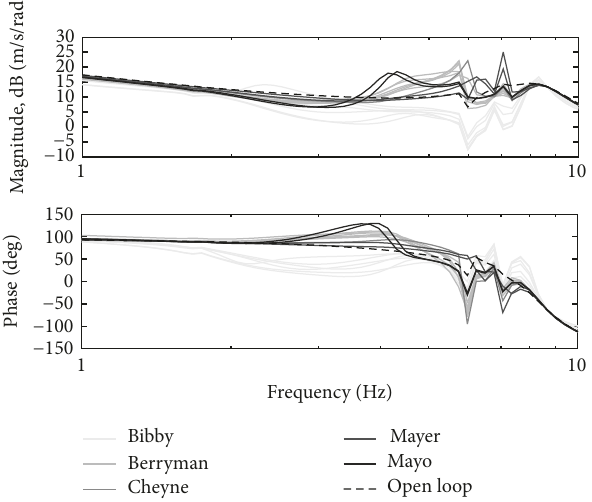
Figure 10: Influence on 𝑤 versus 𝜃 0 of different pilot models.